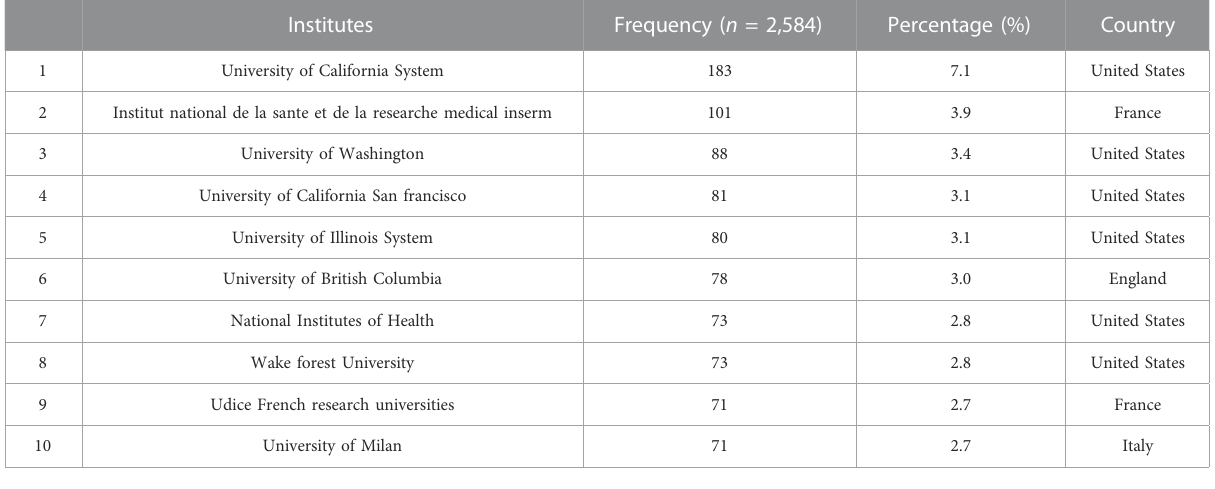
TABLE 3 The Top 10 institutions that published studies on LCAT.